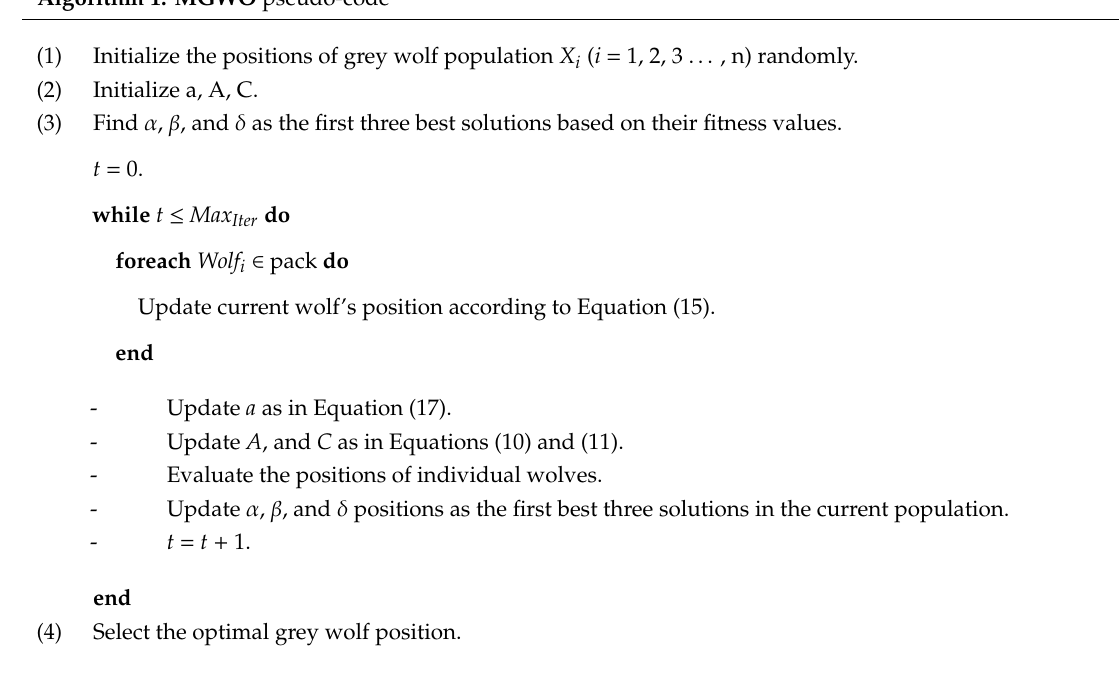
Algorithm 1. MGWO